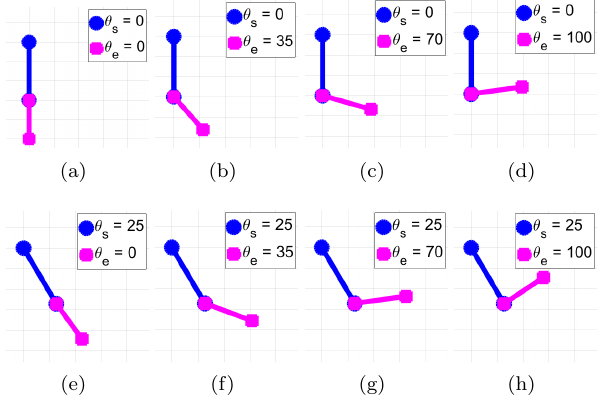
Figure 6: Joint configurations selected for collecting sensors